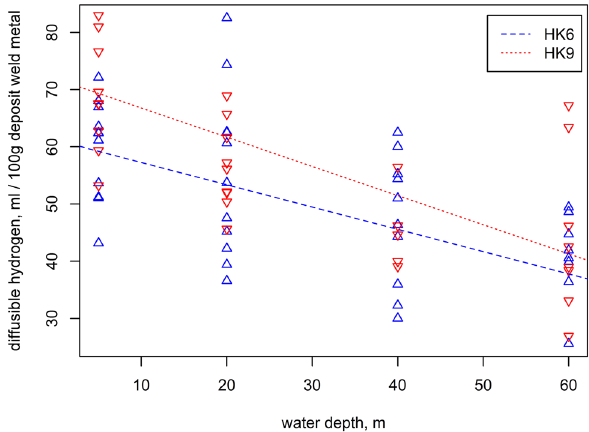
Fig. 7 Adjusted correlation between d and H HK6 and HK9 showing a significant influence of depth. The fits are calculated using regression model (6), with the individual mean masses of deposited weld metal and cellulose contents of each electrode